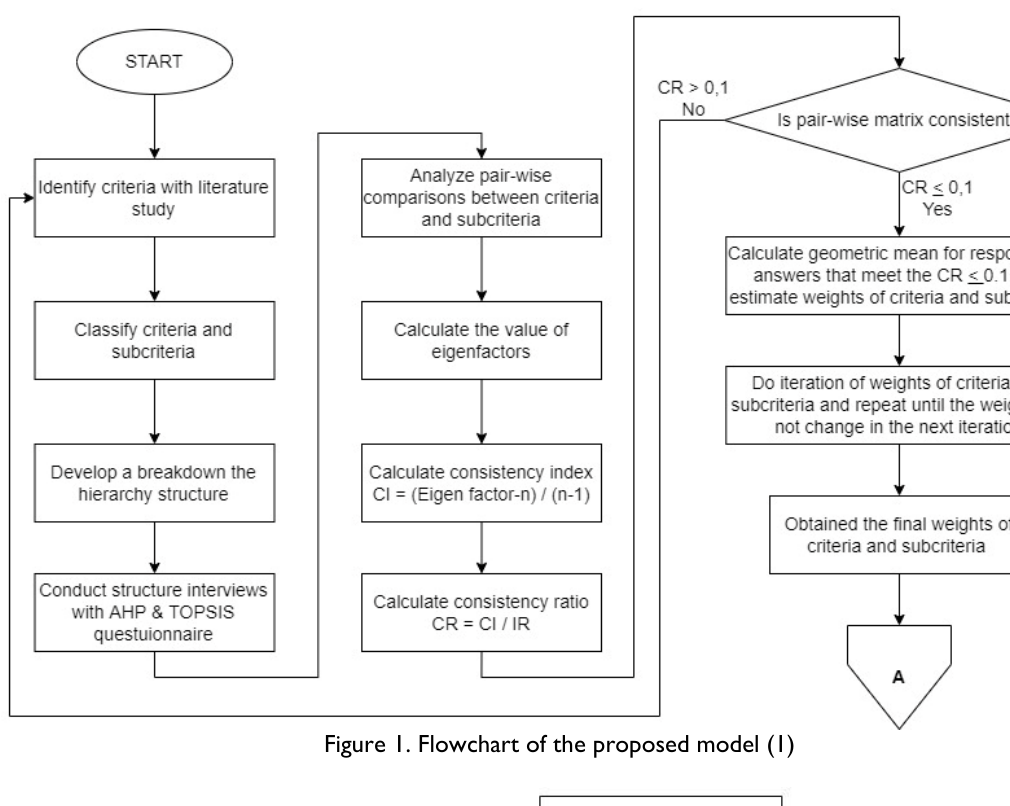
Figure 1. Flowchart of the proposed model (1)